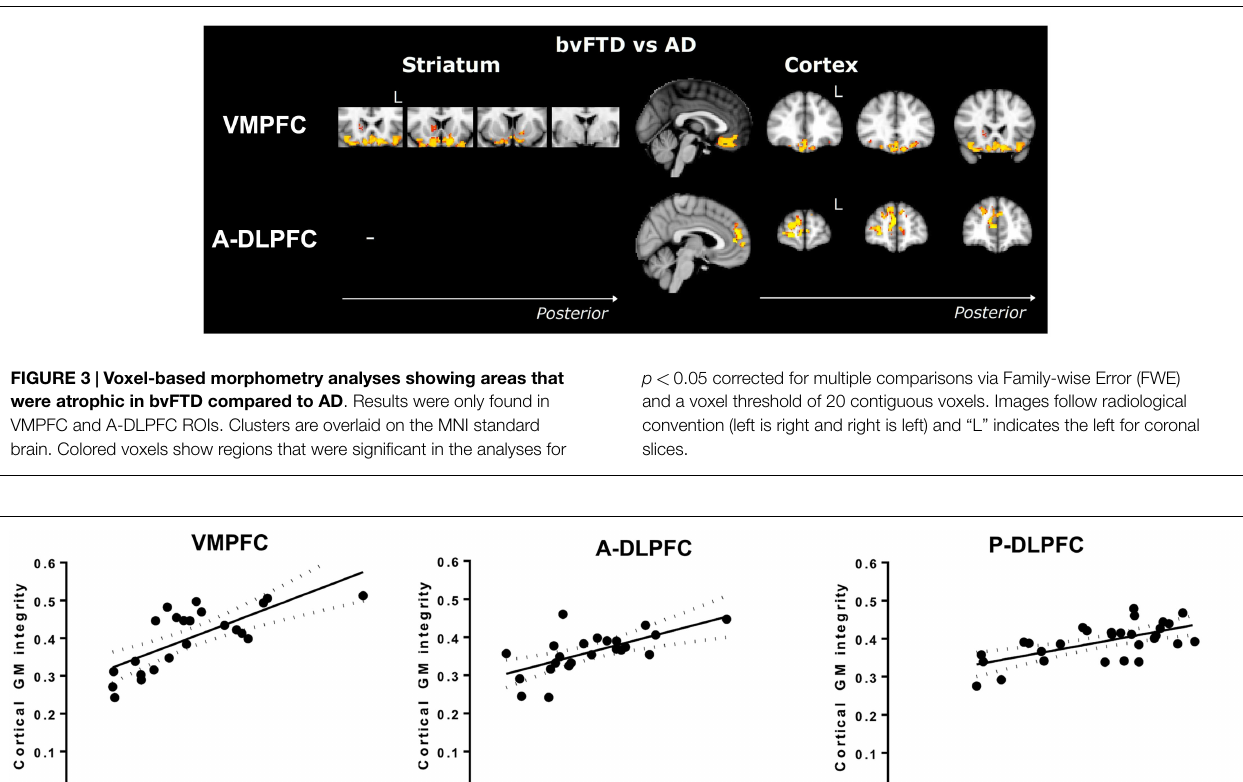
FIGURE 4 | Plots of the correlation between the mean individual grey-matter intensity values extracted from the striatum- VMPFC-connected and the striatum-A-DLPFC-connected and in the